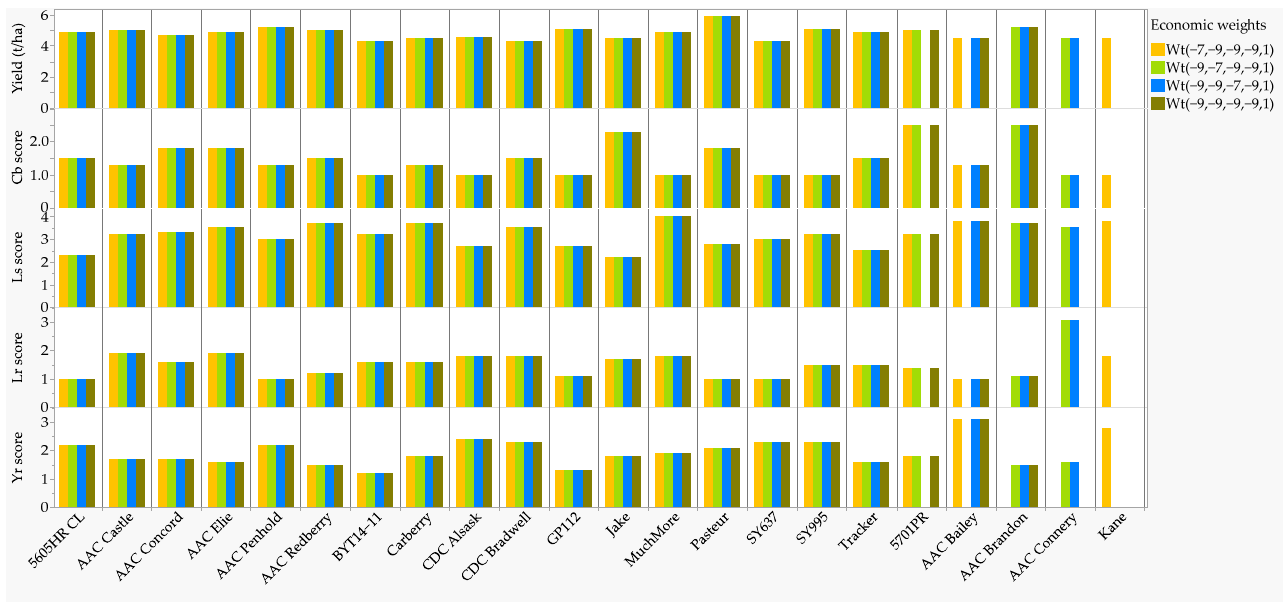
Figure 4. Bar graph of the overall disease scores (BLUE) of the 22 lines and cultivars chosen using 4 out of the 3125 economic weights. Of the 22 genotypes, 17 were selected using all four economic weights, Kane and AAC Connery were selected using one and two weights, respectively, and the remaining three genotypes (5701PR, AAC Bailey, and AAC Brandon) were selected using three weights. See Table S5E for details.